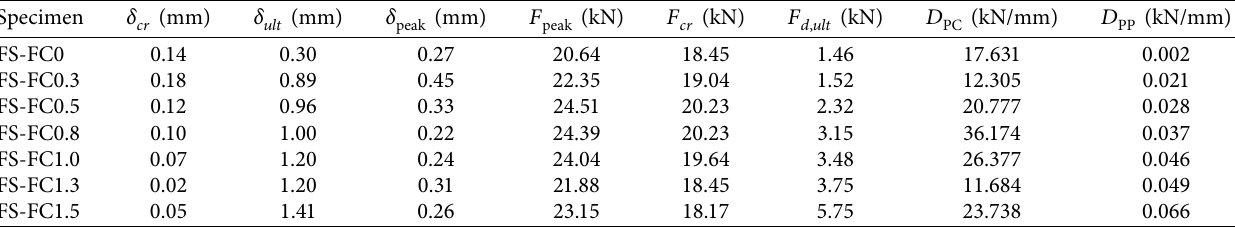
Table 5: Postcracking and postpeak